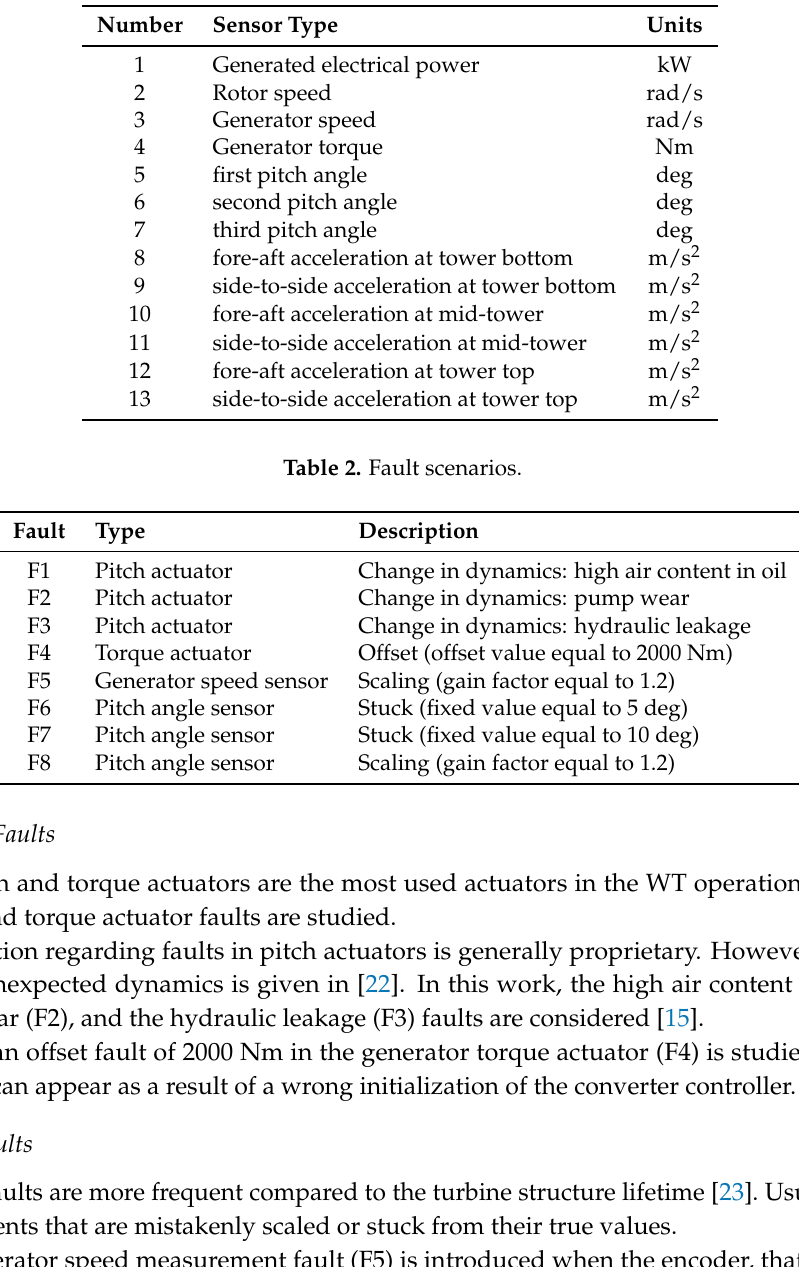
Table 1. SCADA data assumed to be available [15].